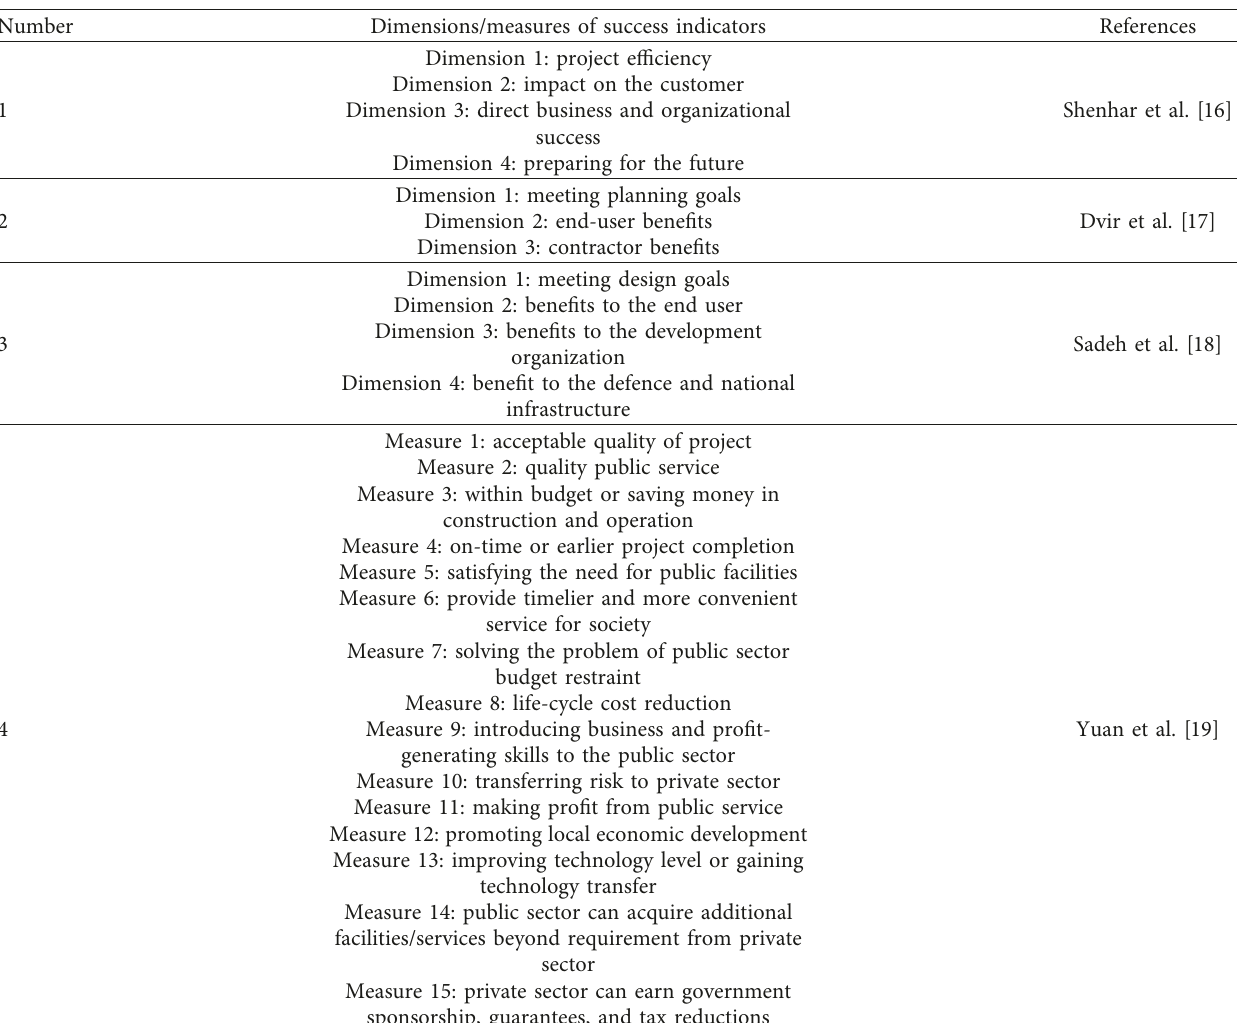
Table 1: Success indicators of PPP